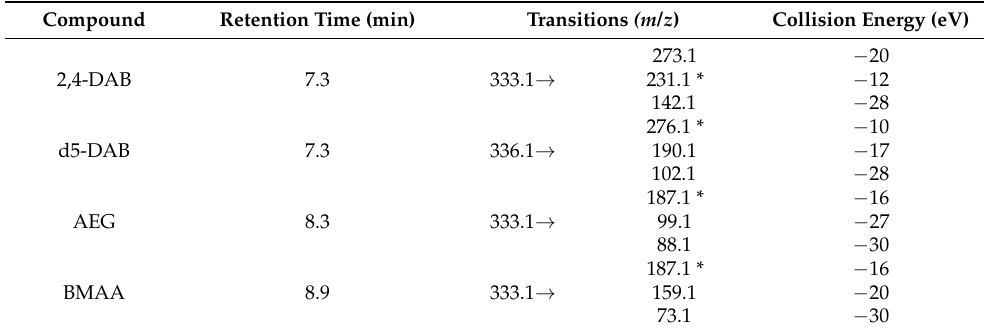
Table 2. MRM and retention parameters for detection of the PCF-derivatised BMAA, 2,4-DAB, and AEG. * denotes ion transition used for